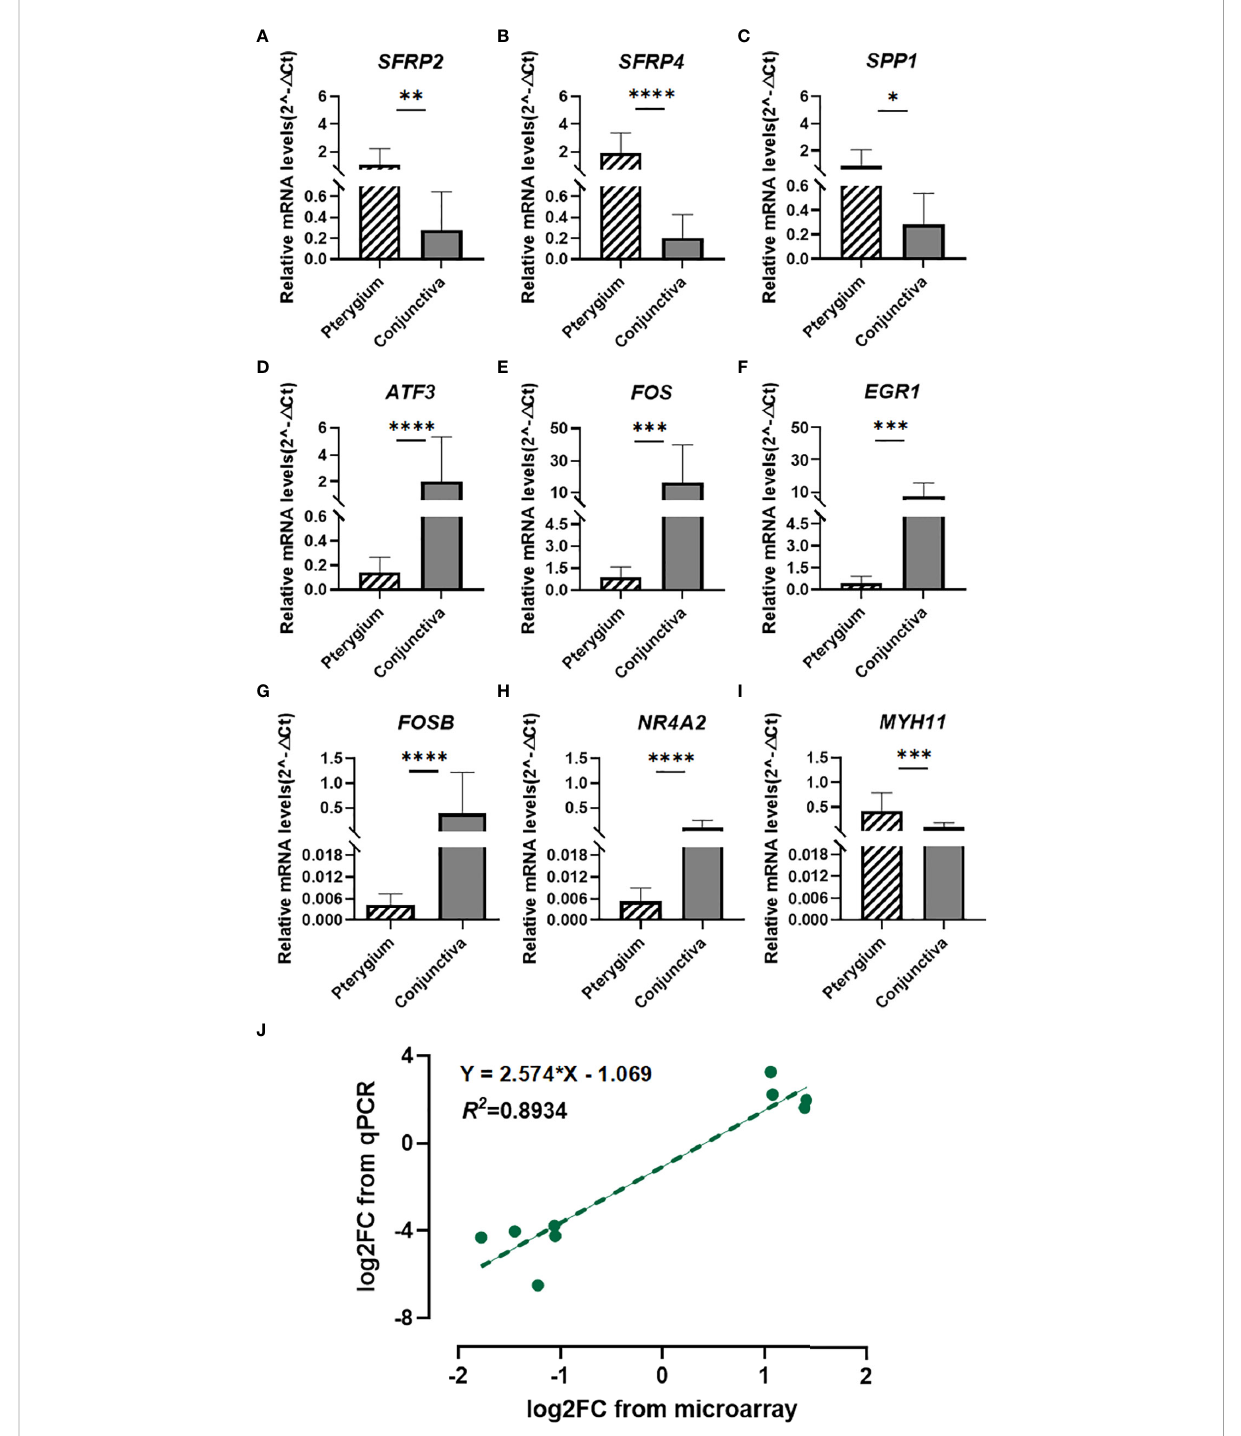
FIGURE 6 Quantitative real-time PCR veri fi cation and Correlation analysis. (A – I) Quantitative real-time PCR validation for SFRP2, SFRP4, SPP1, ATF3, FOS, EGR1, FOSB, NR4A2, and MYH11 . n = 14 for primary pterygium samples and n = 12 for normal conjunctiva samples. *p < 0.05, **p < 0.01, ***p < 0.001, ****p < 0.0001. (J) Correlation analysis between microarray and qPCR data of candidate genes. Linear regression model (green dotted line): y = 2.574x - 1.069, R2 =